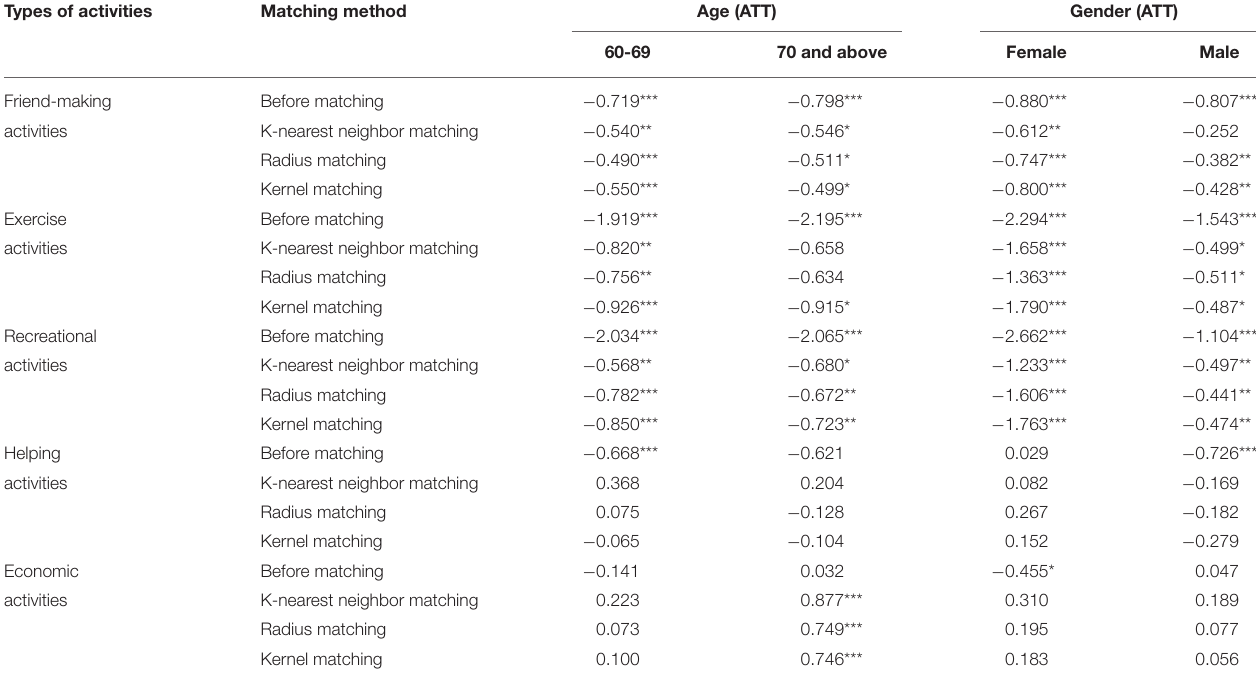
TABLE 8 | Average intervention effect by age and gender matching. Types of